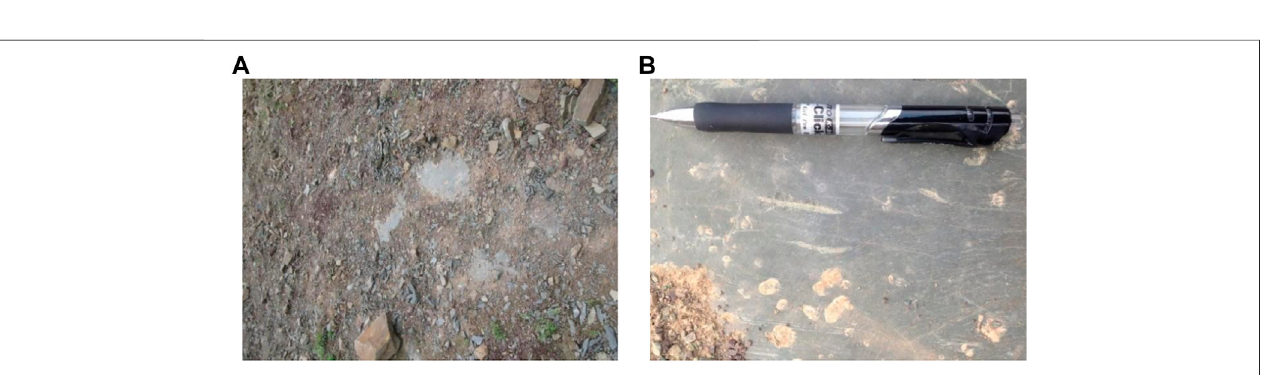
FIGURE 2 | A topographic map after the landslide